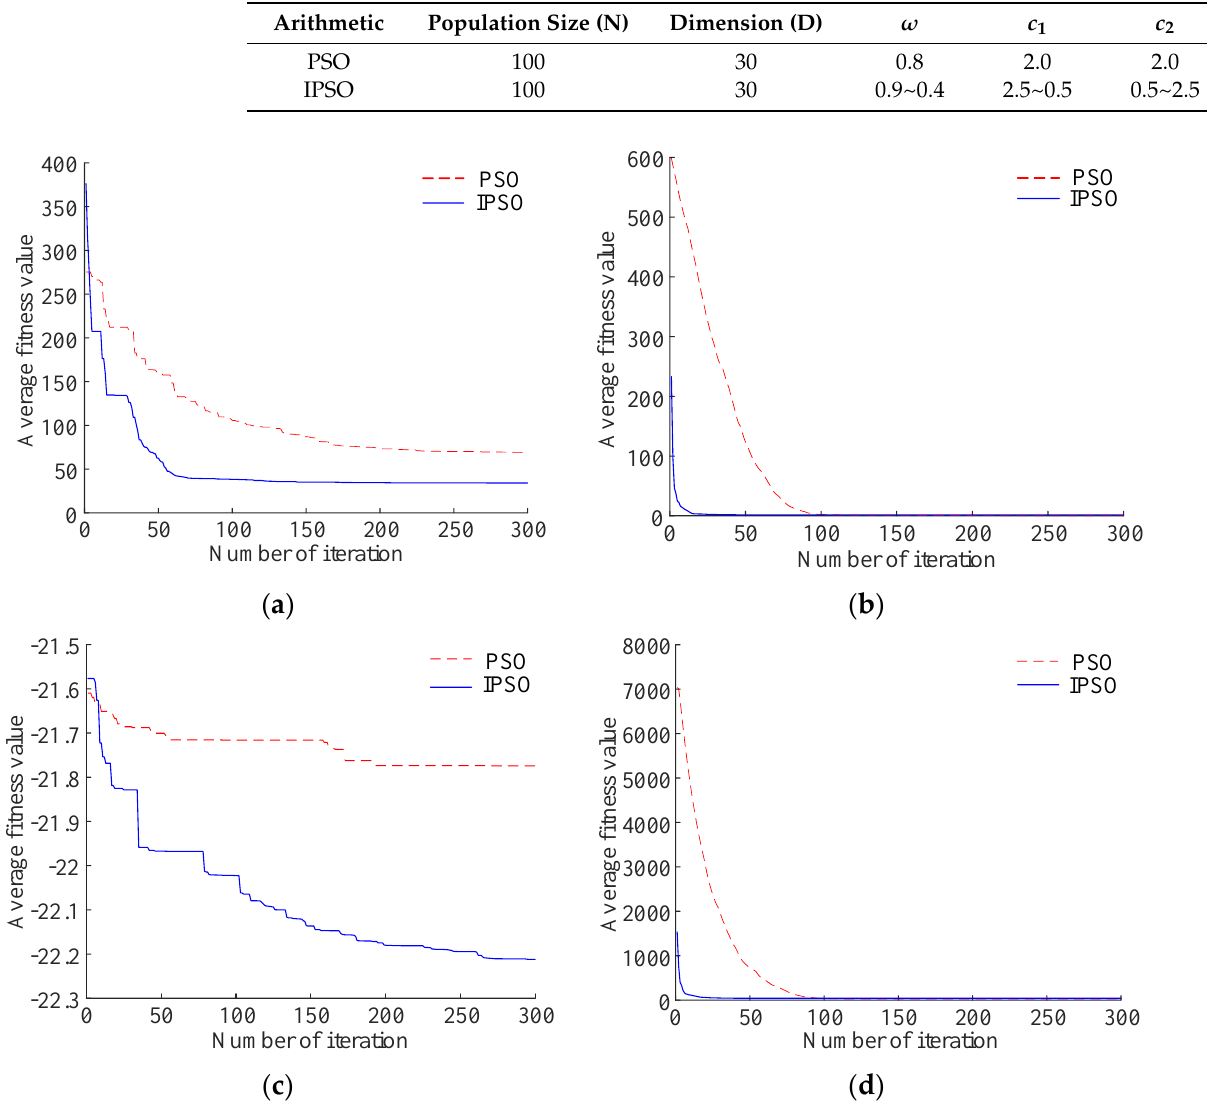
Table 1. PSO and IPSO parameter setting.